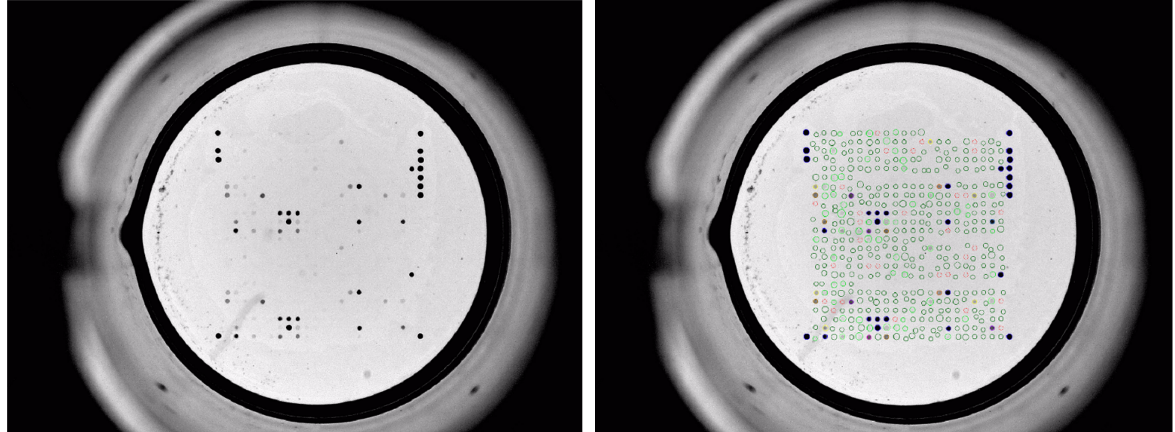
Figure 1. Array results for the ESBL E. coli strain obtained from a Common buzzard ( left ), same array with an interpretation grid for fully automated spot recognition ( right ).